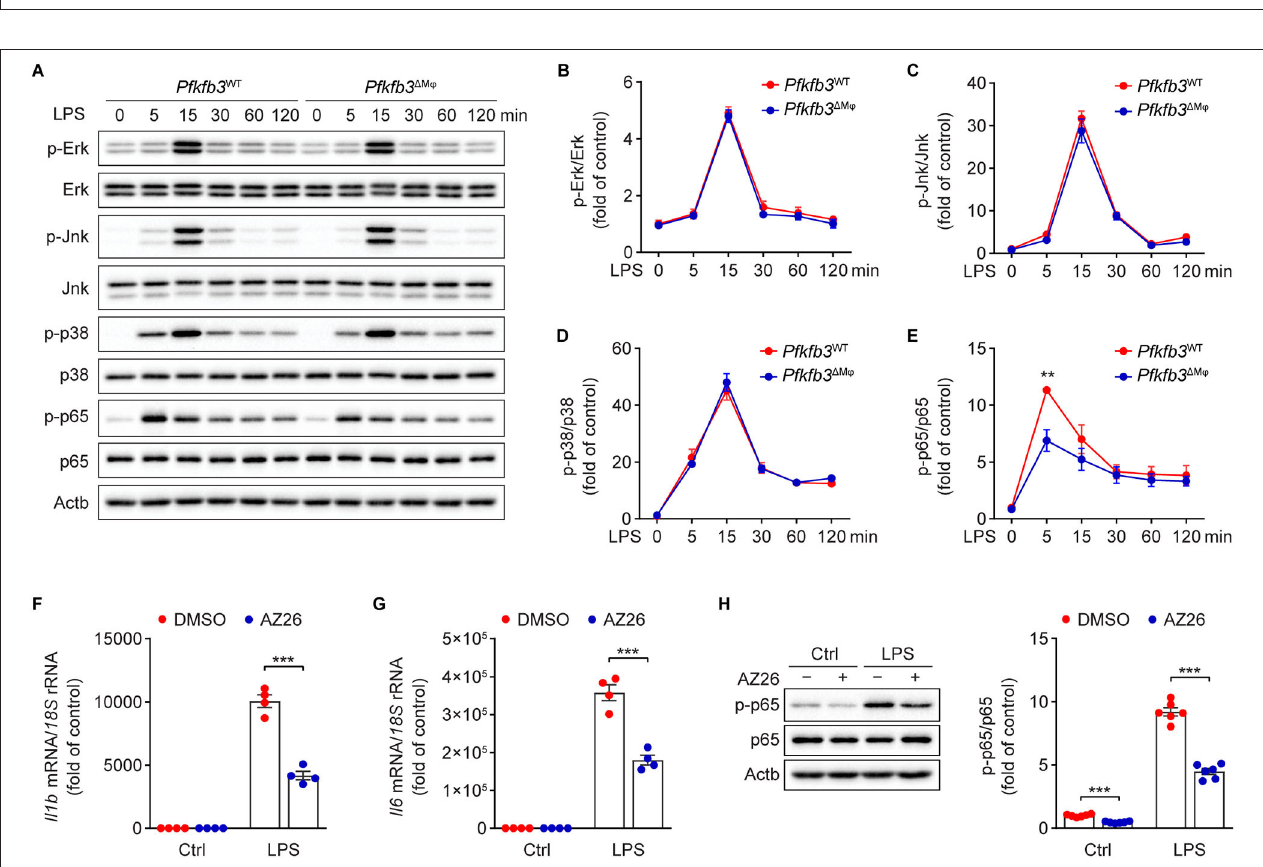
FIGURE 6 | analysis of the mRNA levels of Il1b (D) , Il6 (E) and Nos2 (F) in Pfkfb3 WT and Pfkfb3 1 M φ BMDMs treated with LPS (100ng/mL) for 4h ( n = 6). (G–I) Representative Western blot results of Nos2, Pfkfb3 and Actb in Pfkfb3 WT and Pfkfb3 1 M φ BMDMs treated with LPS (100ng/mL) for the indicated times (G) and relative ratio of Pfkfb3/Actb (H) and Nos2/Actb (I) were quantitated by densitometric analysis of the corresponding Western blots ( n = 4). (J,K) ELISA analysis of Il1b (J) and Il6 (K) secretion in the supernatants of Pfkfb3 WT and Pfkfb3 1 M φ BMDMs treated with LPS (100ng/mL) for 16h ( n = 4). (L) Quantification of NO secretion in the